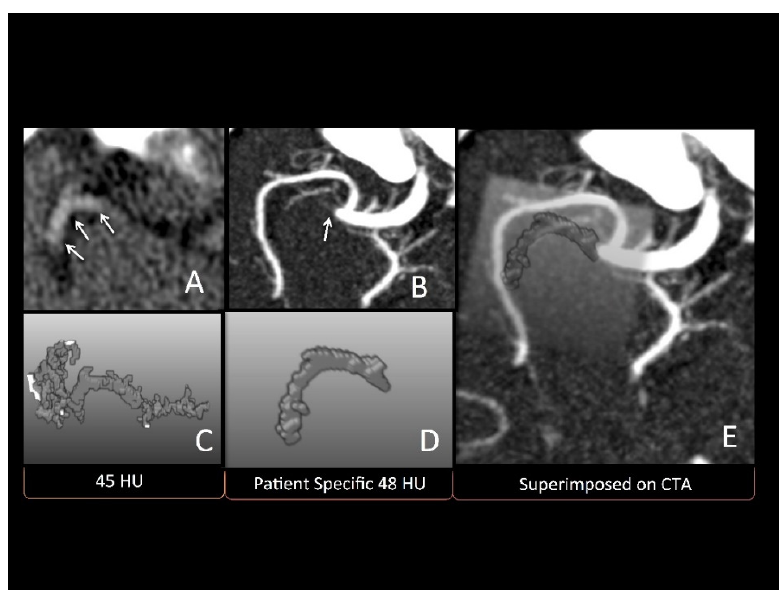
Figure 2. Patient with right distal middle cerebral artery M1 occlusion extending into the M2: ( A ) hyperdense sign in NCCT (marked by the arrow); ( B ) thrombus in baseline CTA; ( C ) three-dimensional model using conventional 45 HU threshold, which does not accurately depict CTA thrombus; ( D ) patient-specific threshold of 48 HU; ( E ) three-dimensional model using patient-specific HU threshold super-imposed onto CTA.